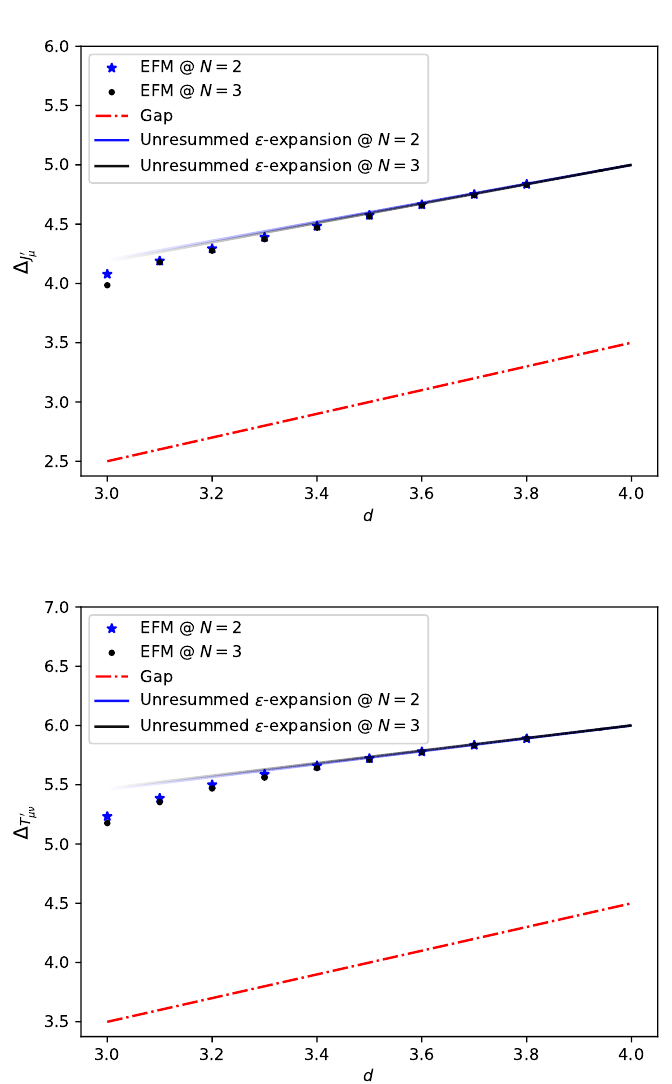
Figure 6: Subleading operators in 4 of the 5 channels where gap assumptions were made (continued from fig. 5). Top: Spin-1 A channel. Bottom: Spin-2 S